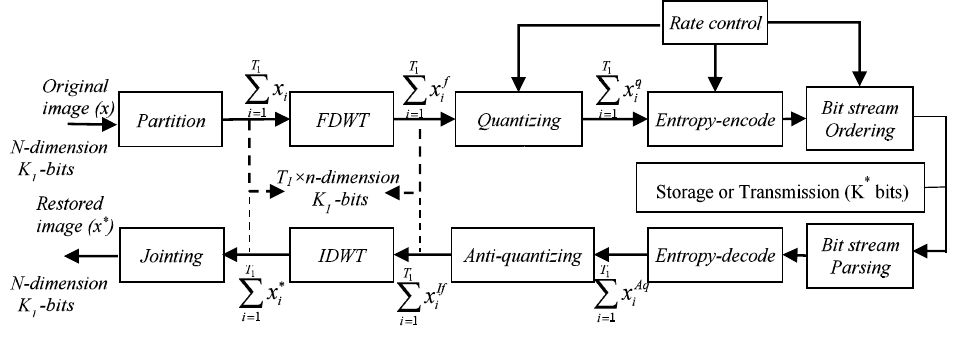
Figure 11. The workflow of the JPEG2000 algorithm.